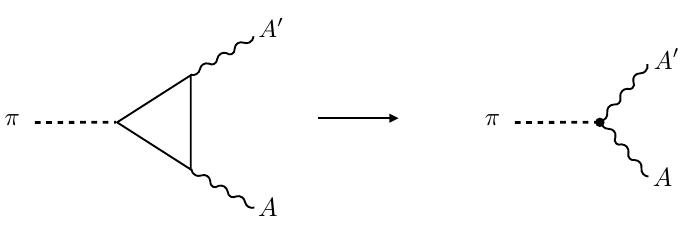
Figure 5 . Anomalous coupling of a photon and a hidden photon to a